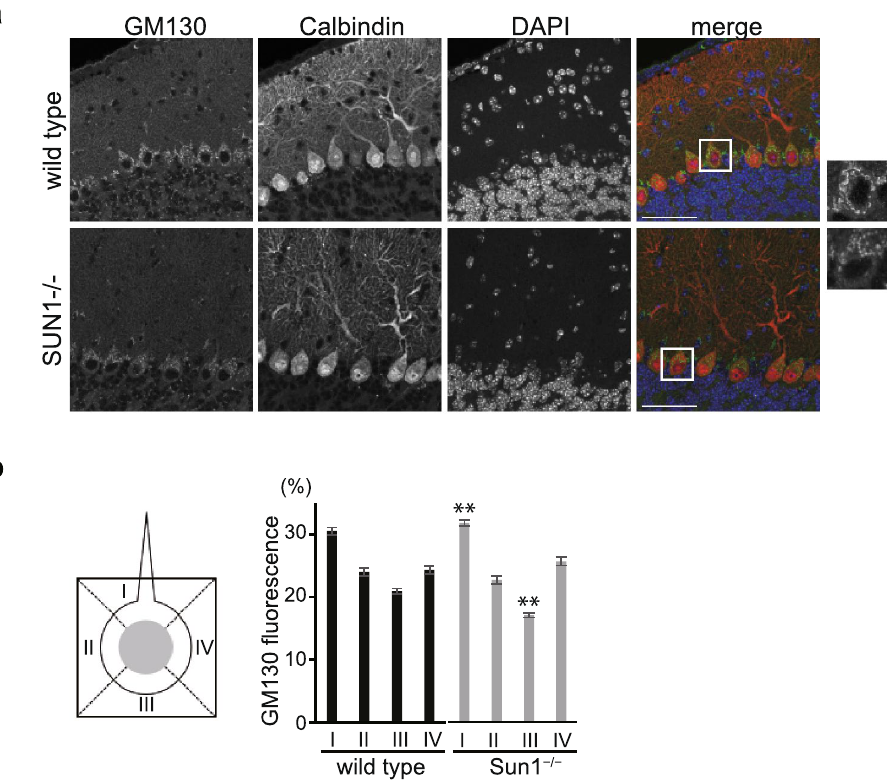
Figure 5. SUN1 functionally associates with Golgi organization in vivo. ( a ) The cerebella from 30-day old male wild-type and Sun1-knockout mice were stained using anti-GM130 pAb and anti-calbindin (a Purkinje cell marker protein) mAb. Bar, 20 µm. The panels on the right are enlarged images of the indicated region in the adjacent panels on the left. ( b ) Golgi distribution was quantified using GM130 staining as the average percentage of total cellular fluorescence in each of the four quadrants (shown at left). The results were obtained from the quantification of 10 < Purkinje cells in each genotype. Data are presented as the mean ± sem, ** P < 0.01, compared with the same region in wild-type tissues.